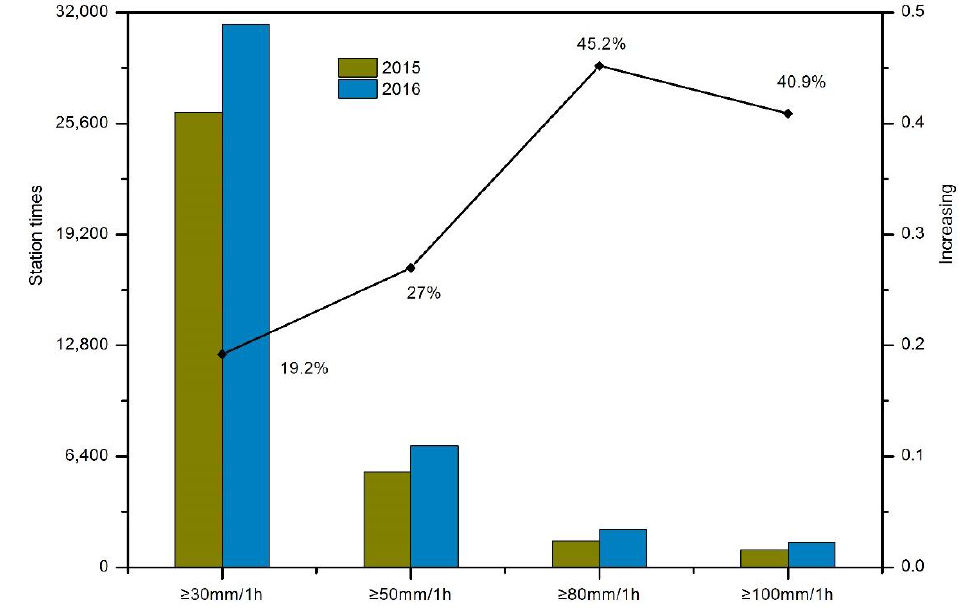
Figure 9. Comparison of rain between 2015 and 2016 (34,030 base stations).